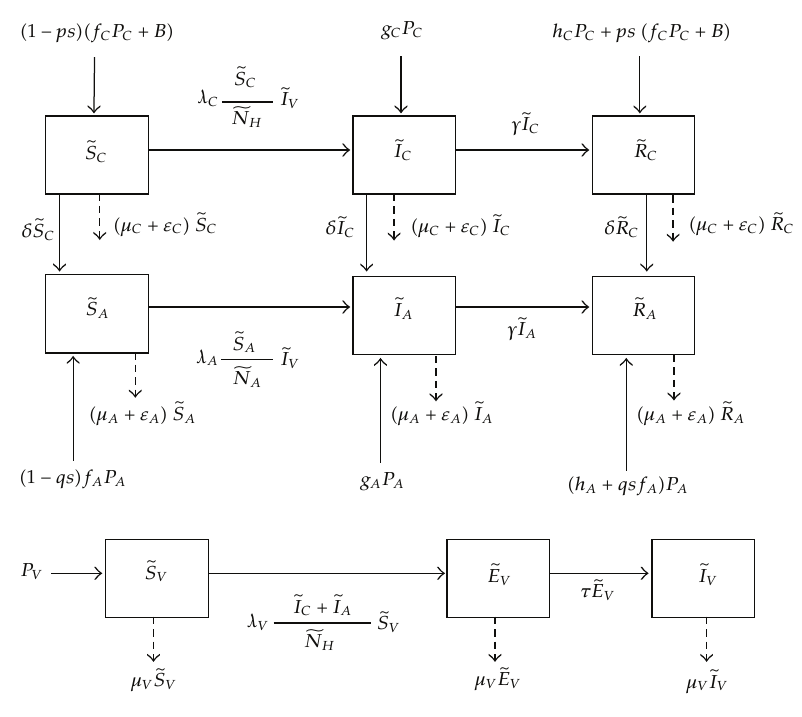
Figure 1: A two-age-class dengue transmission